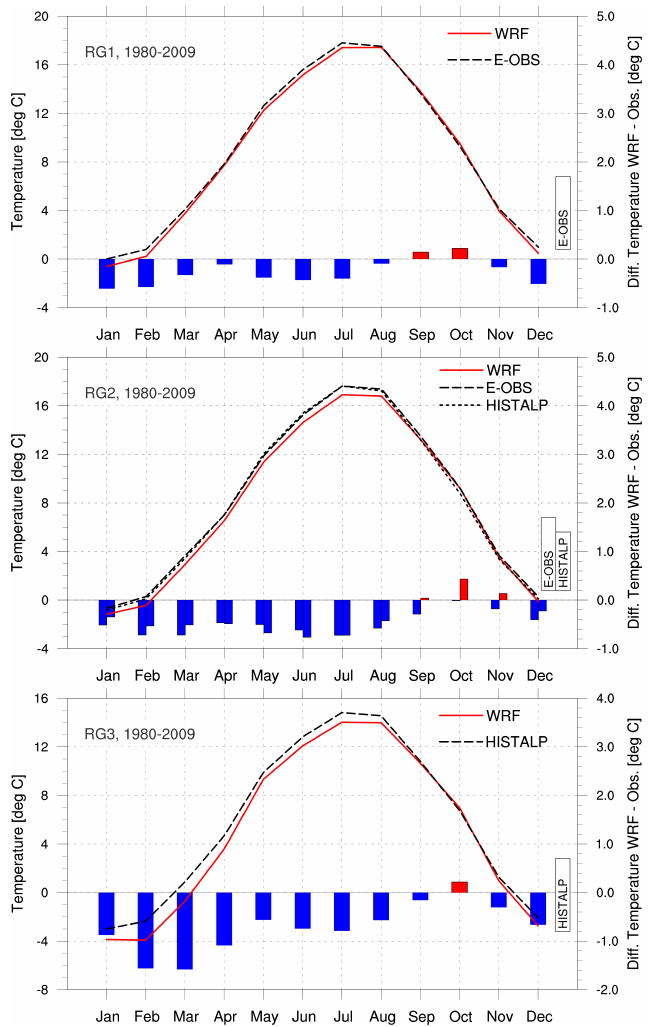
Figure 3. Mean annual cycle 1980–2009 of temperature for the reanalysis simulation and the observation datasets, and the monthly model bias averaged for RG1 (top), RG2 (center), and RG3